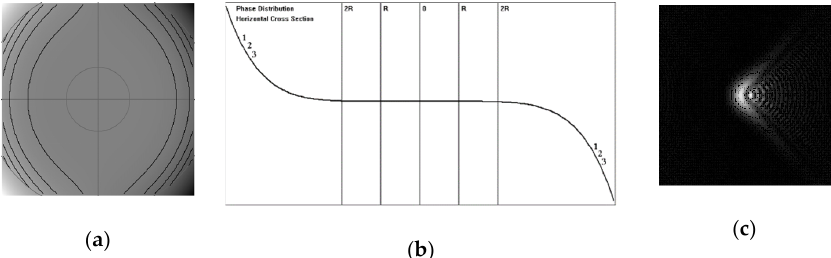
Figure 4. The same as in Figure 2, the phase was specified by polynomial No. 7 (coma). Phase surface ( a ), cross-sections of phase surface ( b ) and corresponding amplitude distribution ( c ) are shown. Three cross-sections coincide ( b ).